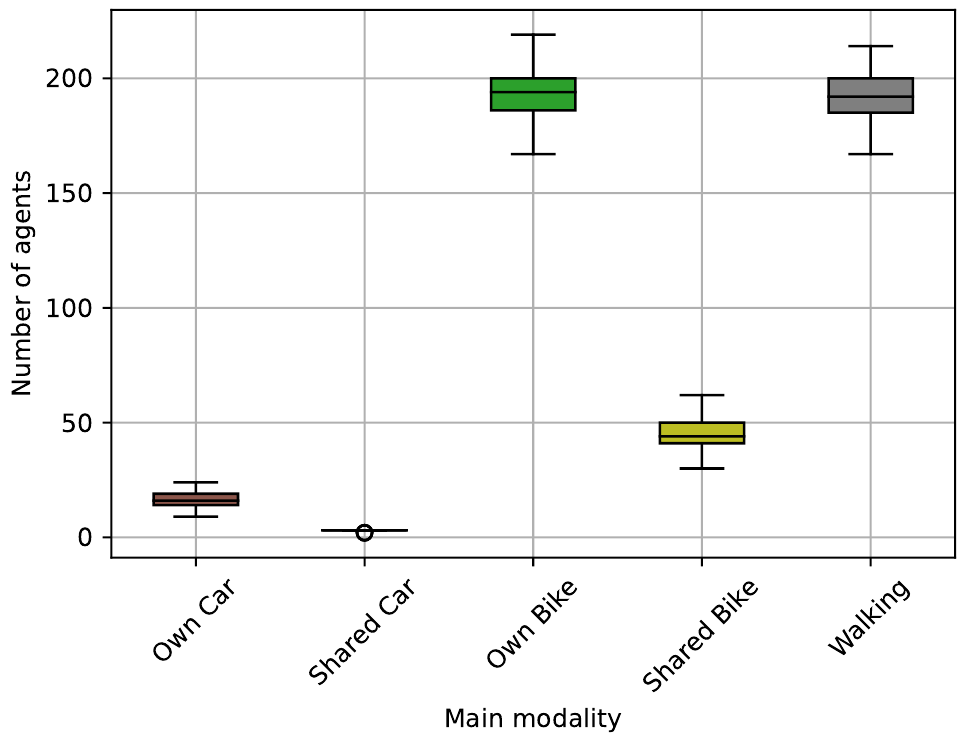
Figure 8. Comparison of average distribution of agents’ main modality (solid bars) with real-world data (hatched bars).